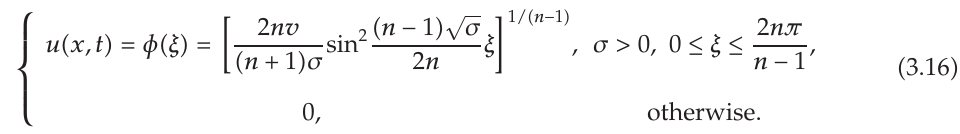
Figure 1: The solution u in (cid:2) 3.15 (cid:3) shows a shape of compacton for parameters v (cid:8) 2 , and σ (cid:8) 1 .